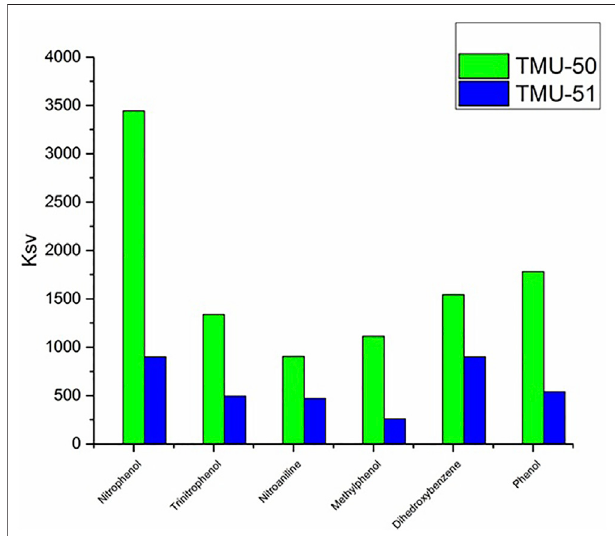
FIGURE 8 | Comparison graph between TMU – 50 and TMU-51 in different NACs sensing.